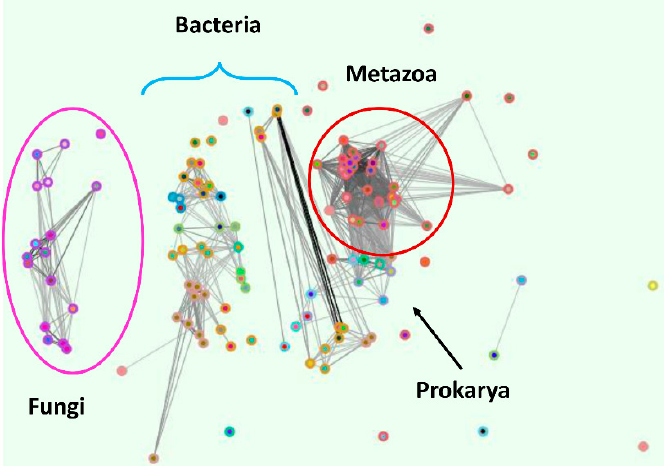
Figure 3. Fungal Zrt3, Prokaryote ZupT, Metazoan Zip11 pan-domain supercluster (OG5_127397). Clustering performed using OrthoMCL. Note the separation of eukaryotic (Fungi and Metazoan) subclusters by prokaryotic proteins.